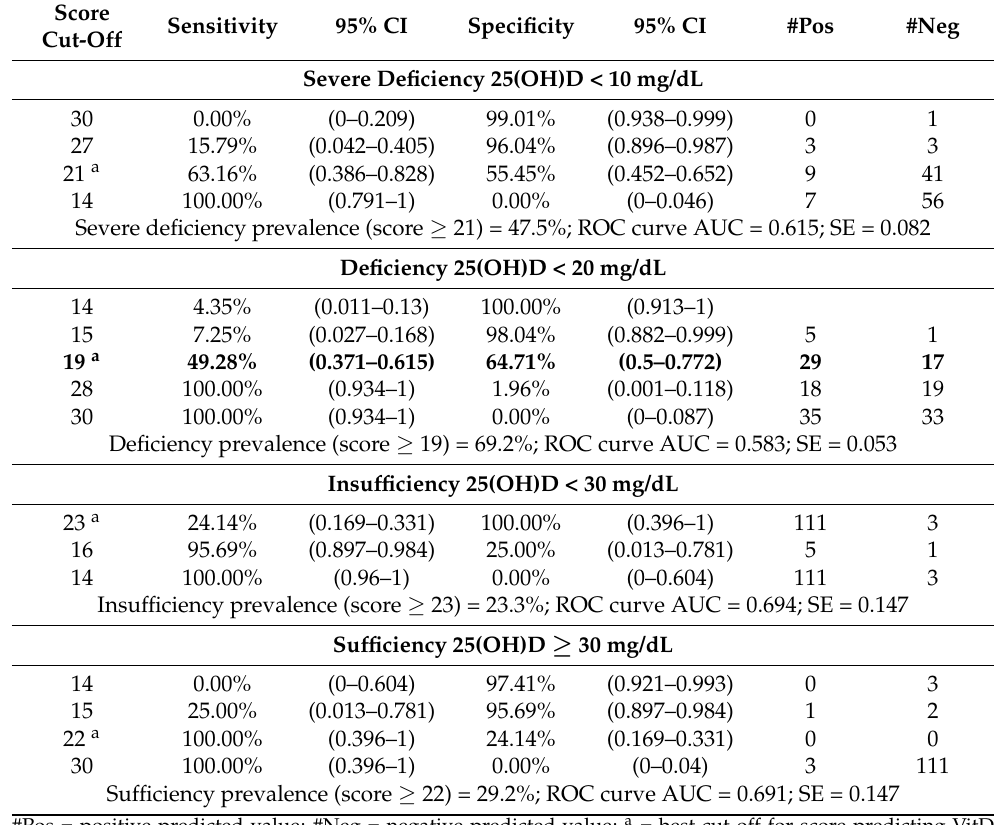
Table 4. Questionnaire score cut-off to discriminate between subjects with severe VitD deficiency and those with VitD sufficiency according to VitD levels.